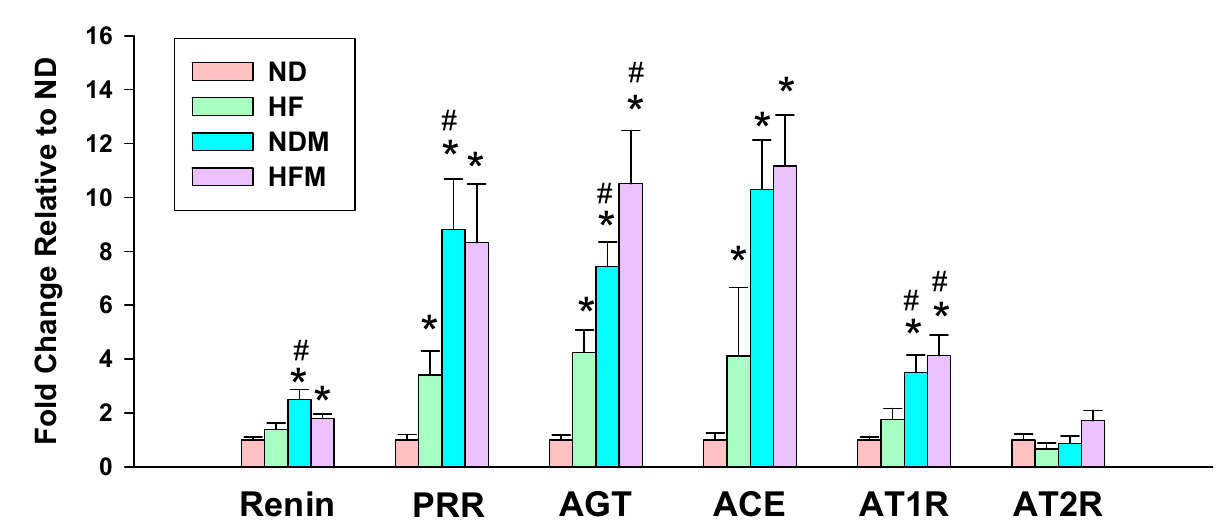
Figure 6. Effect of high-fructose diet (HF) and minocycline administration (M) on the renin–angiotensin system in 12-week-old male offspring kidneys. PRR = (Pro)renin receptor; AGT = angiotensinogen; ACE = angiotensin-converting enzyme; AT1R = angiotensin II type 1 receptor; AT2R = angiotensin II type 2 receptor; Data are shown as means ± SEM; N = 5–8/group; * p < 0.05 vs. ND; # p < 0.05 vs. HF.